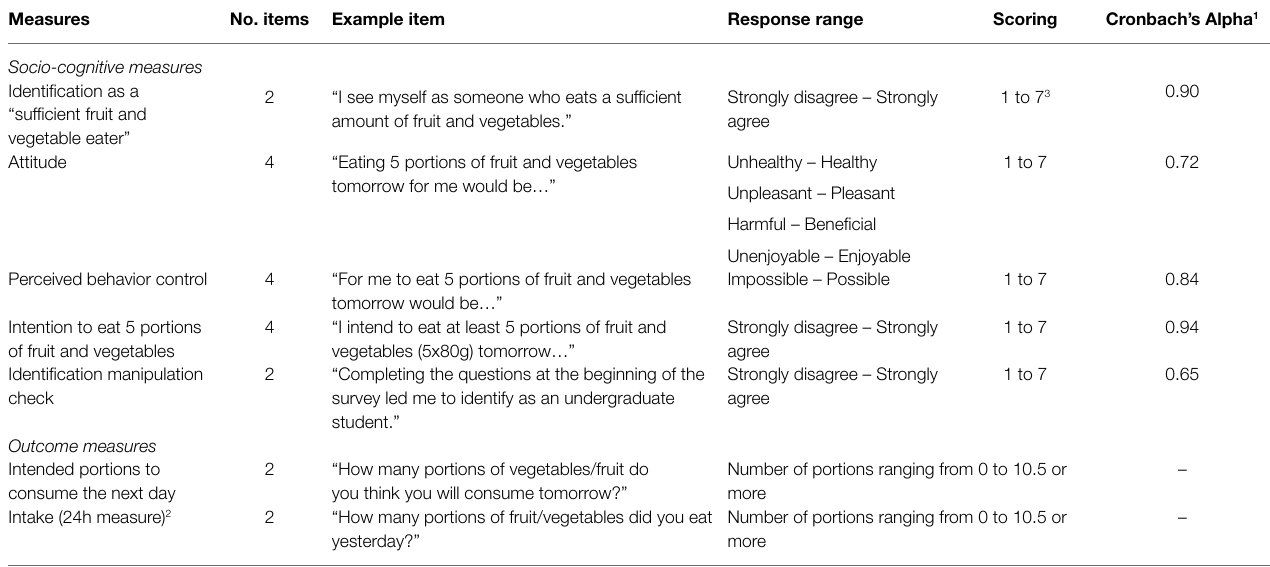
TABLE 2 | Measures and corresponding example items, response range, and